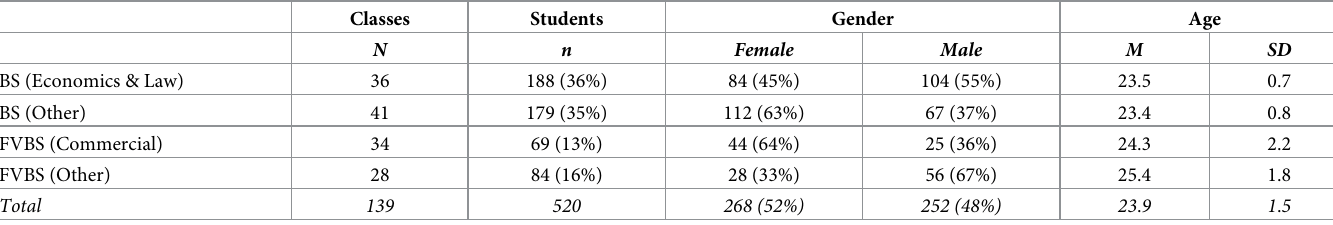
Table 2. Longitudinal sample